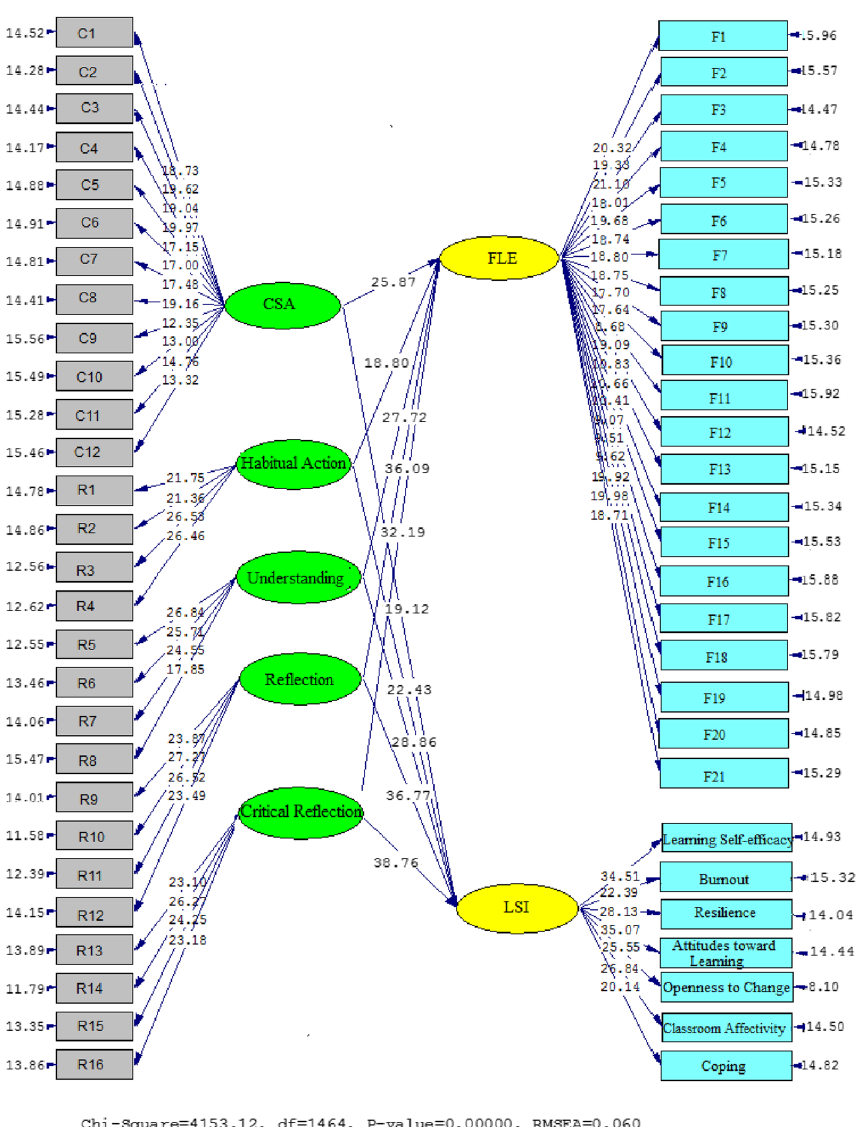
Fig. 5 T -values for path coefficient significance (model 2)